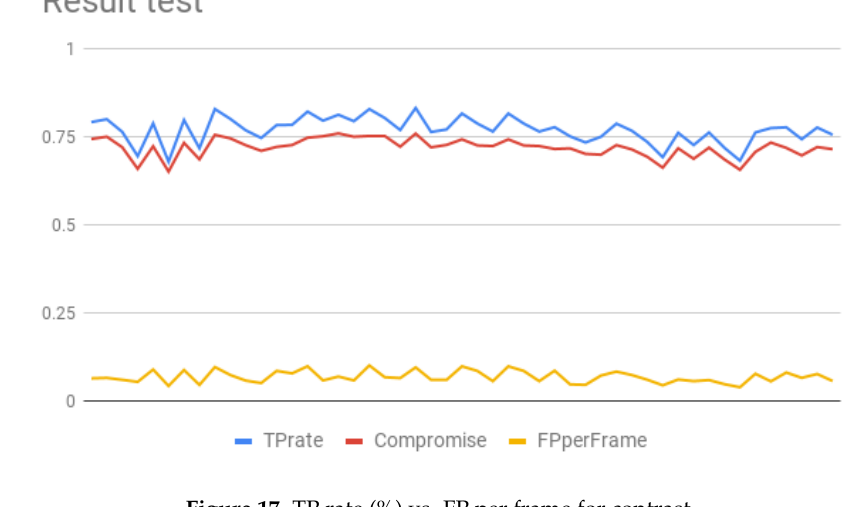
Figure 17. TP rate (%) vs. FP per frame for contrast.